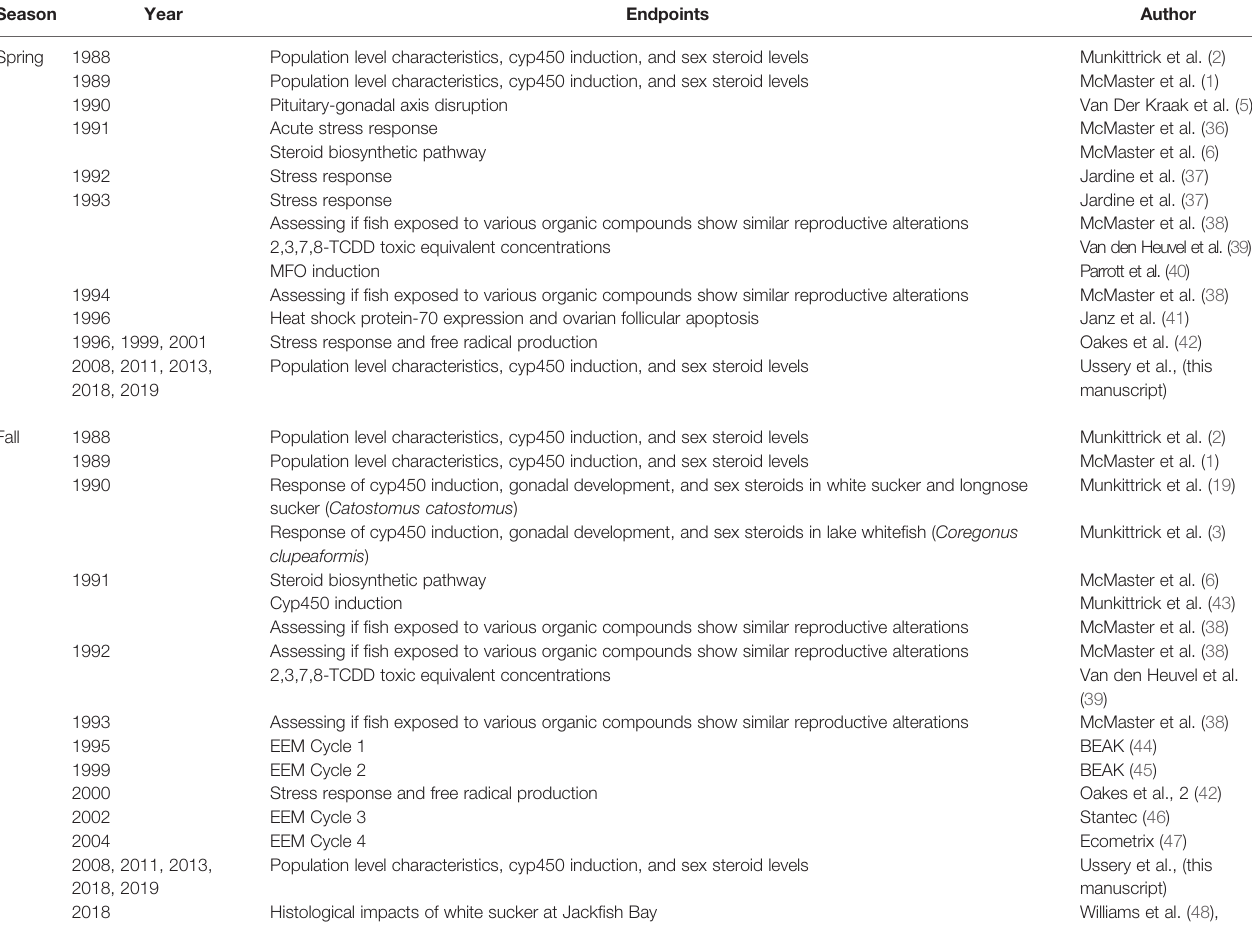
TABLE 1 | Summary of main endpoints from studies that have been conducted at Jack fi sh